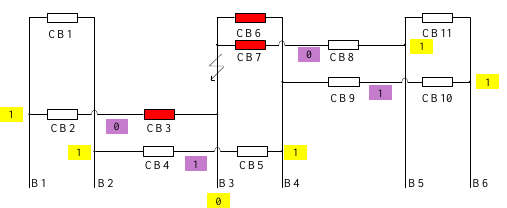
Figure 3. Example of bus fault: The ordered set C = {CB3, CB6, CB7} is obtained by the SCADA system.